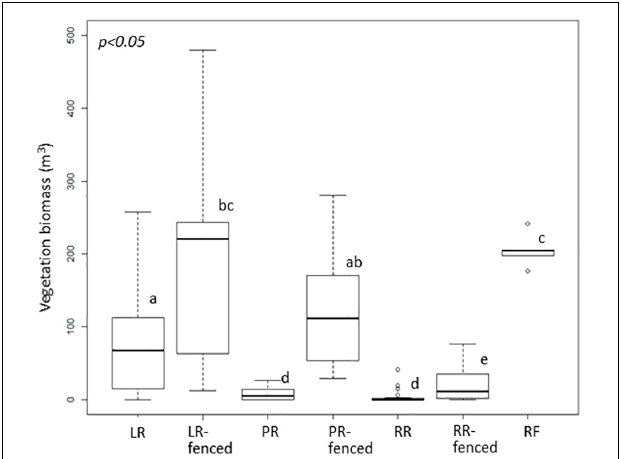
FIGURE 2 | Boxplot of vegetation biomass above the deer line in each treatment after windthrow and in the mature, natural mixed forest. Significant differences according to a permutation test ( p < 0.05) are indicated by different letters. LR, legacy retention; LR-fenced, LR enclosed by a deer fence; RR, residual rows; RR-fenced, RR enclosed by a deer fence; PR, planting rows; PR-fenced, PR enclosed by a deer fence; and RF, mature, natural mixed forest (reference